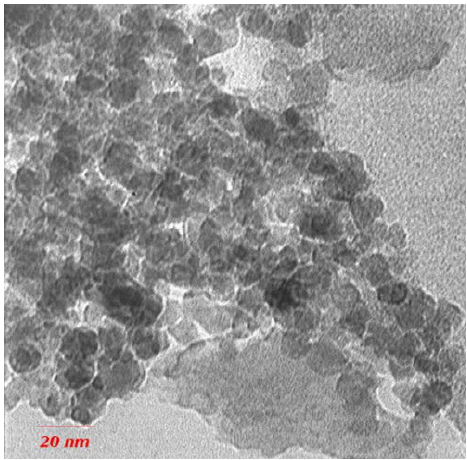
Fig. 1. TEM image of nanocrystalline MgAl